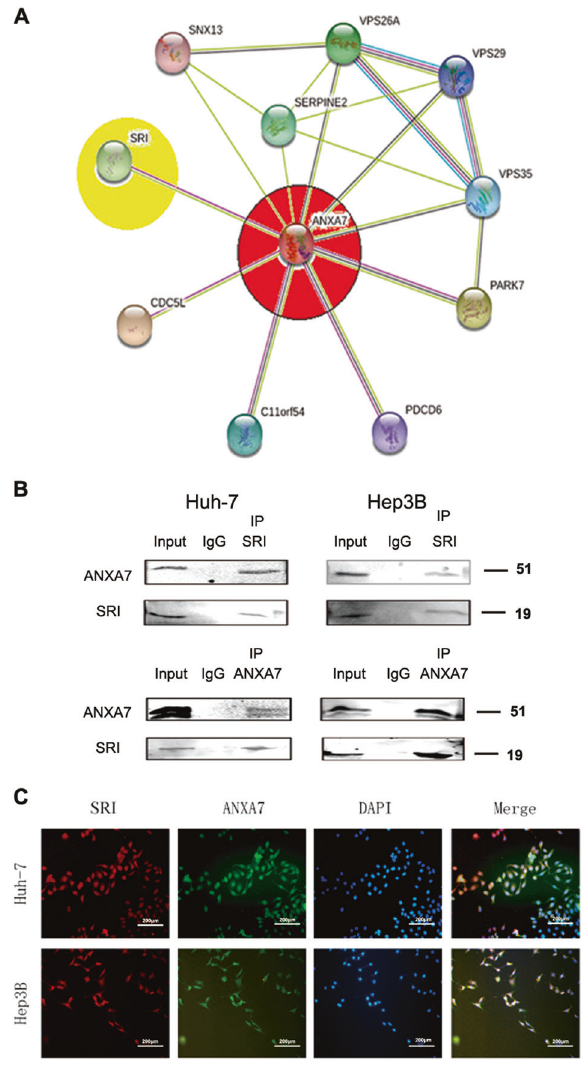
Fig. 2 ANXA7 and SRI are interacting proteins. A There may be a potential interaction between ANXA7 and SRI, which was analyzed by the STRING database. B co-IP assay showed the interaction between ANXA7 and SRI in Huh-7/Hep3B cells. C Cellular immuno- fl uorescence proved that ANXA7 and SRI are colocalized in the cytoplasm and cell membrane in Huh-7/Hep3B Statistical analysis The experimental data were statistically analyzed by using GraphPad Prism 8.0 and SPSS 17.0. Differences between the two groups were evaluated by Student ’ s t test. One-way ANOVA was used to perform multiple comparisons. Metastatic lymph node in vivo experiments was calculated by Chi-square test. The data were presented as mean ± SD and statistical signi fi cance was set at p < 0.05.